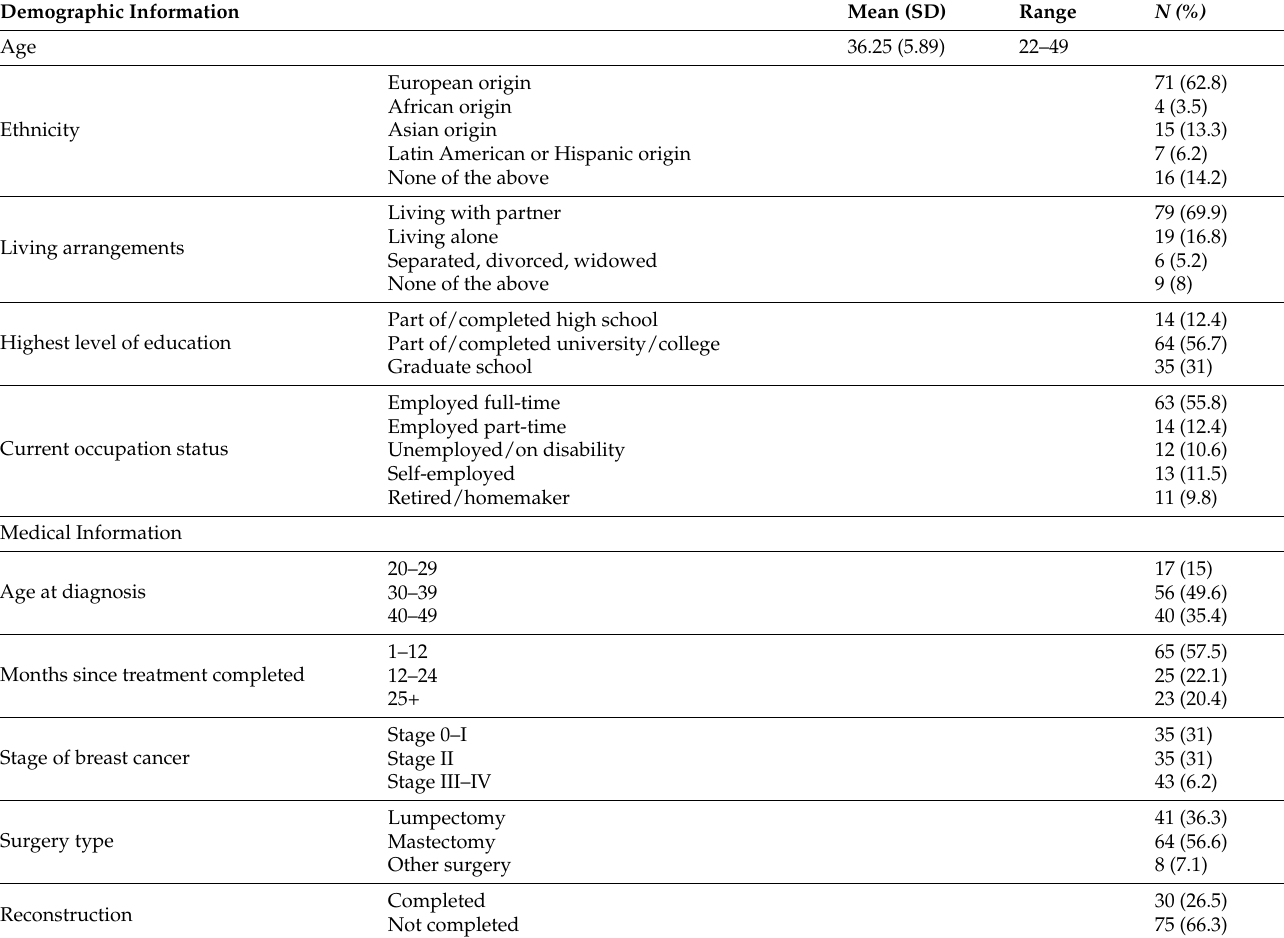
Table 1. Summary of participant demographic and medical